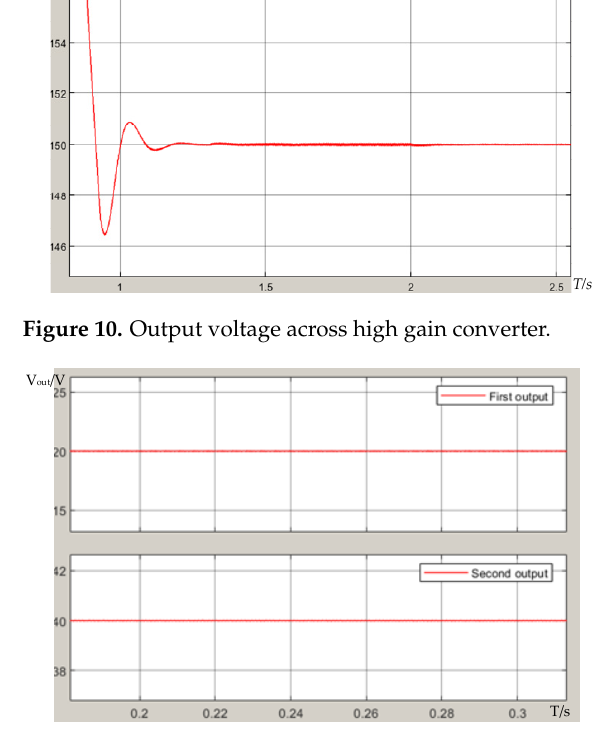
Figure 11. Output voltage of the dual output converter.